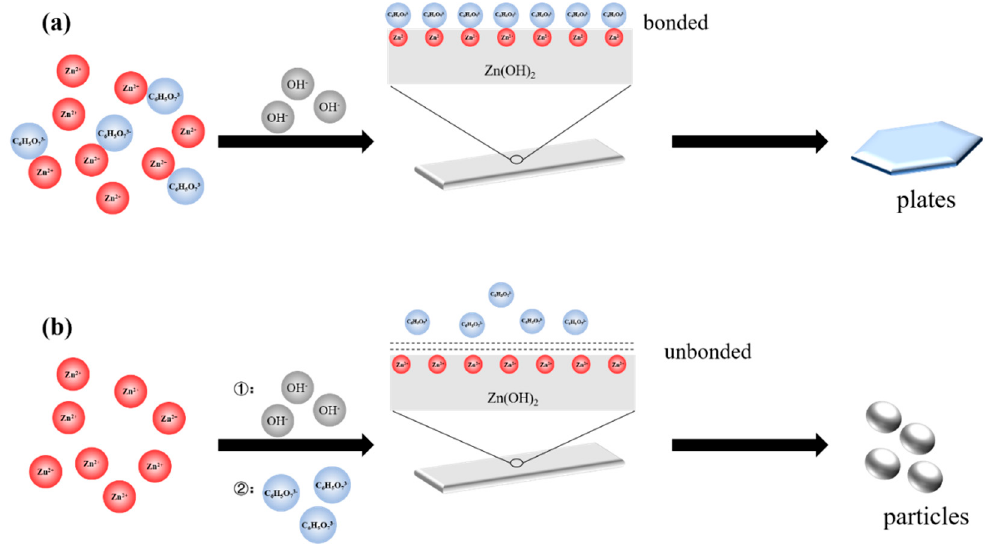
Figure 8. Schematic illustration of mechanism of citrate capping effect in: ( a ) OS route; and ( b )TS route.